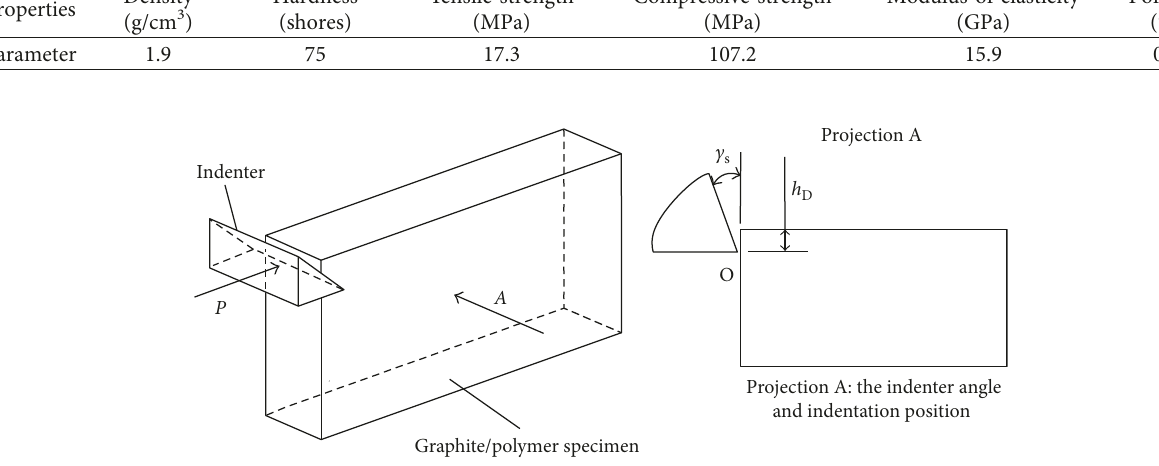
Figure 2: Schematic drawing of edge-indentation experiment.